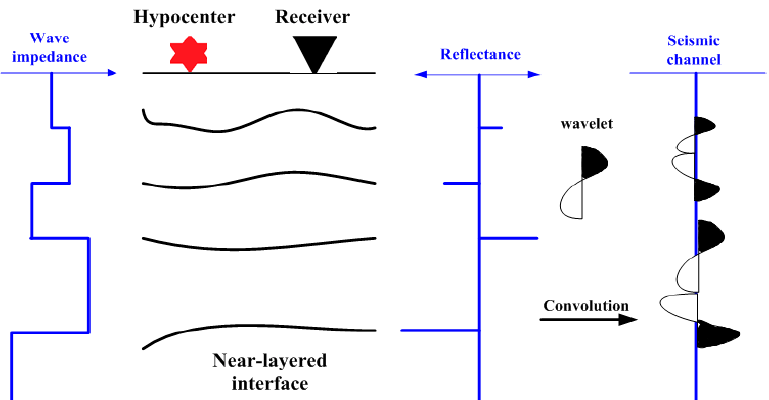
Figure 2. Schematic diagram of the relationship between wave impedance, seismic wavelet, reflection coefficient and formation structure.